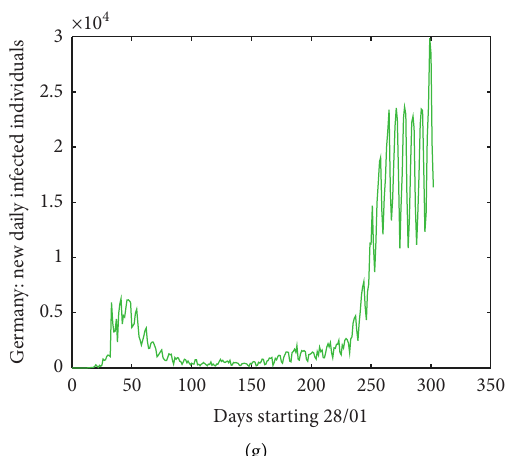
Figure 2: Number of new daily infected individuals in (a) Belgium, (b) France, (c) Hungary, (d) Italy, (e) Spain, (f) the United Kingdom, and (g) Germany.